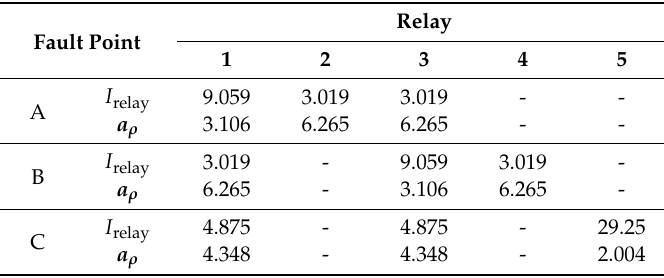
Table 10. a ρ Constants and relay currents for Case